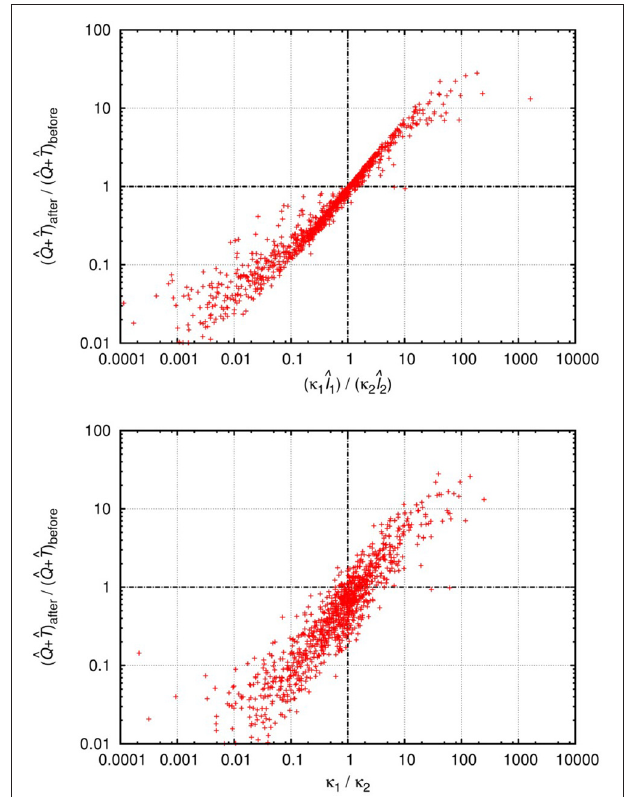
FIGURE 3 | Relative change of the total uninfected target cell count ( ˆ Q + ˆ T ) after and before successful superinfection, plotted against the total rates of activation ( κ 1 ˆ I 1 ) / ( κ 2 ˆ I 2 ) (top) or the ratio of the activation parameters κ 1 /κ 2 (bottom) of the two virus strains in the HIV-induced activation model. The results of 20,000 simulation runs with successful superinfection are shown. In each run, all parameters were drawn randomly with uniform distribution from the intervals presented in Table A5 (Appendix); the cases with healthy (uninfected) cell counts between 500 and 1,500 per µ L were used for the analyses. Both axes are